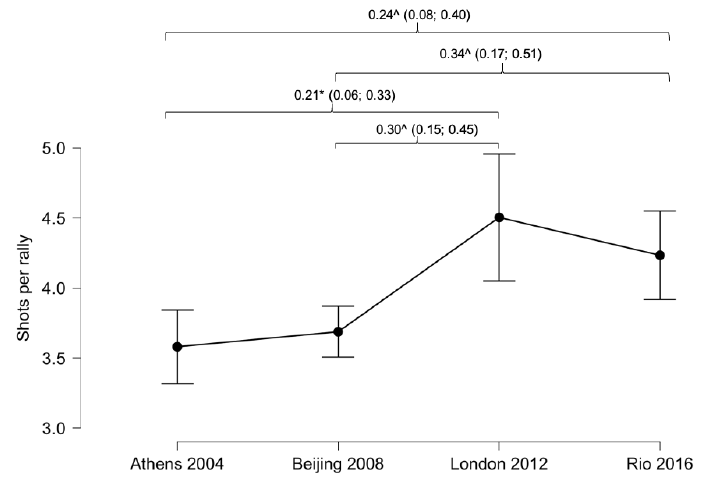
Figure 2. Differences in shots per rally comparing Paralympic Games. Lines denote mean (95 CI). Effect sizes (±95% CI). * = p < 0.05; ^ = p < 0.01.